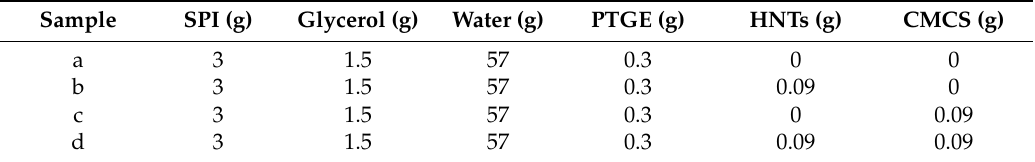
Table 1. Different formulations of Soy Protein Isolate (SPI)-based films a–d.